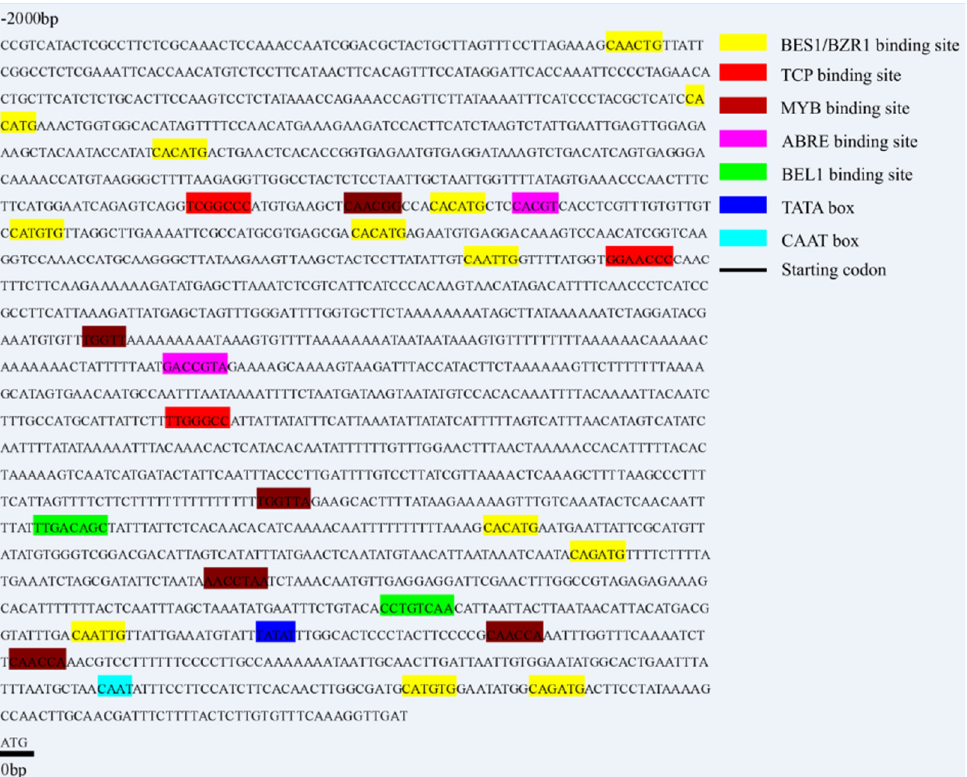
Figure 1. The nucleotide sequence and bioinformatics analysis of MdCoL promoter by PlantCARE and PlantRegMap. Different colored blocks represent different transcription factors’ binding sites or cis-acting elements. The short black line shows the start codon of MdCoL .